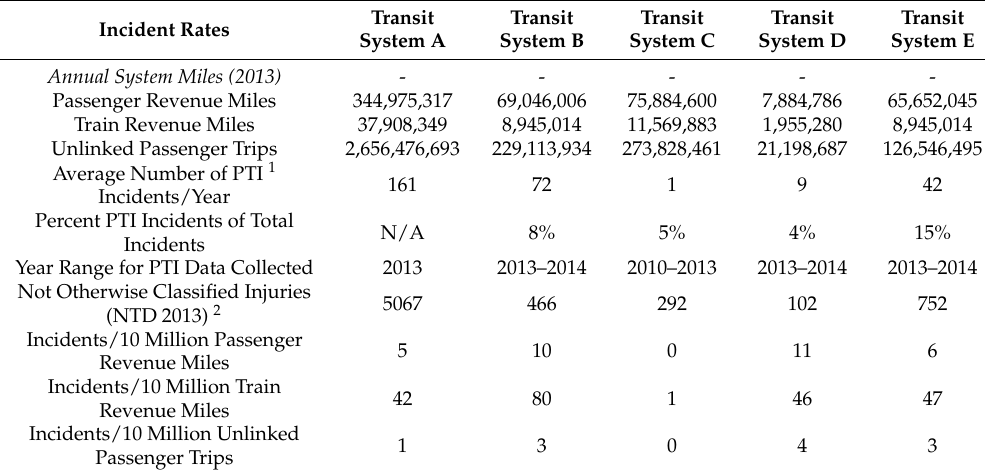
Table 1. Comparison of the five systems that provided data for platform/train and platform/guideway safety